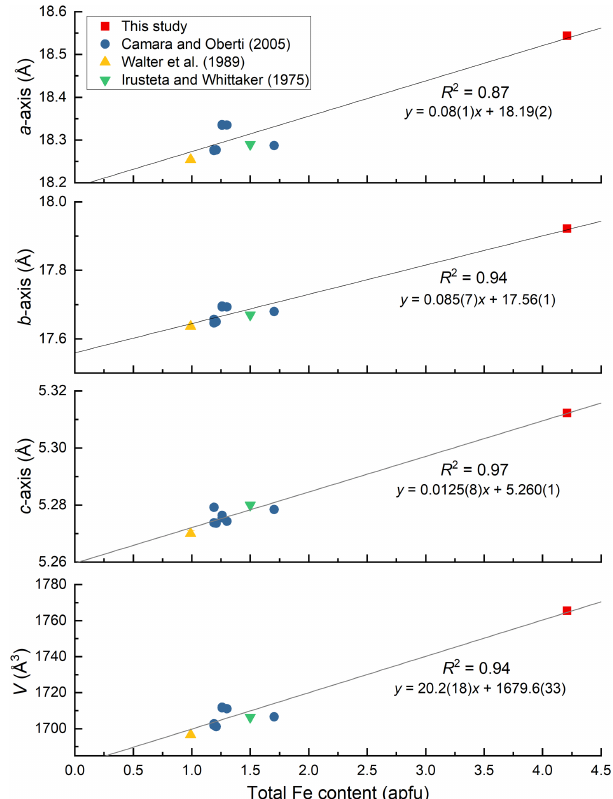
Figure 7. Variation of unit-cell parameters against total Fe content (apfu) in holmquistites. Error bars are within the size of symbols. The unit-cell parameters of holmquistite studied by Irusteta and Whittacker (1975) were originally given in Whittaker (1969). The standard deviations were not given in Whittaker (1969).